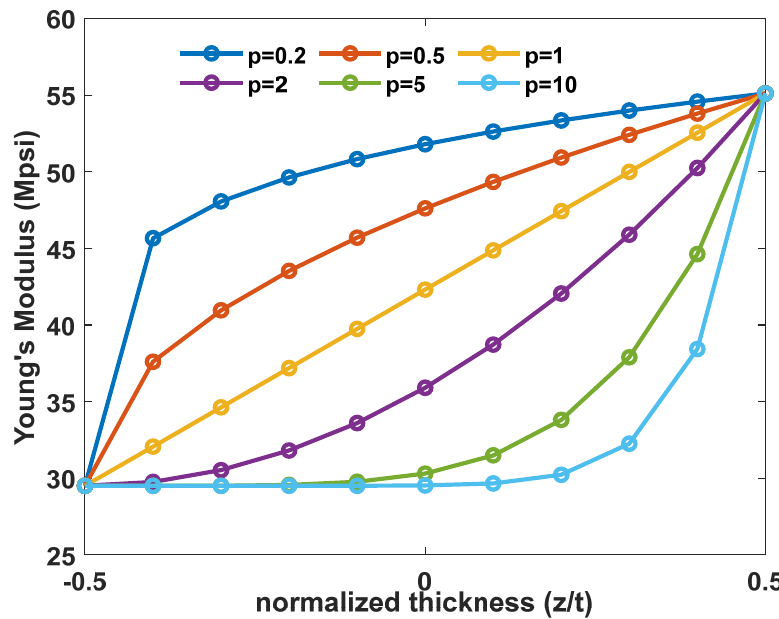
Figure 1. The variation of the power index on the young’s modulus of